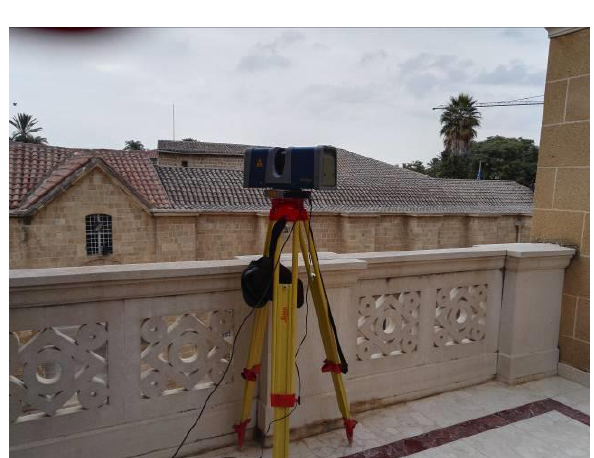
Figure 5. Acquisition project